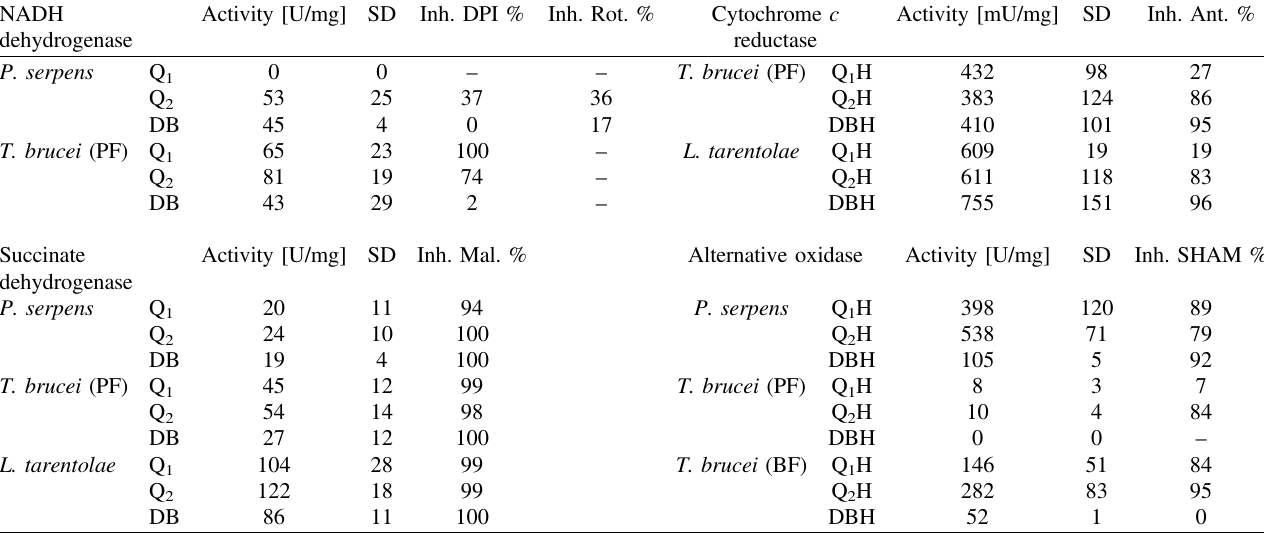
Activity [U/mg] SD Inh. DPI % Inh. Rot. % Cytochrome c